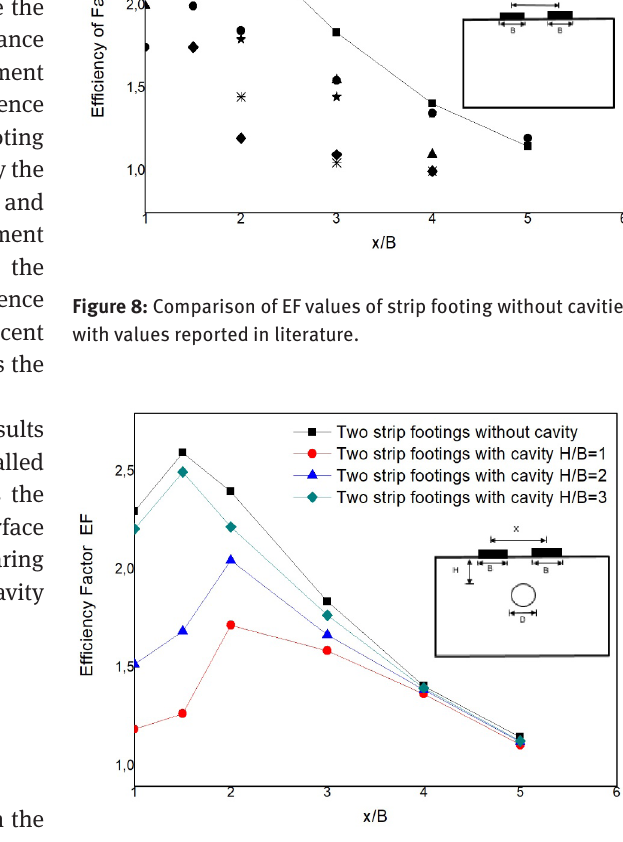
Figure 9: Variation of EF as a function of x/B in the following cases: two strip footings without cavity and with cavity (H/B = 1; H/B = 2 and H/B =